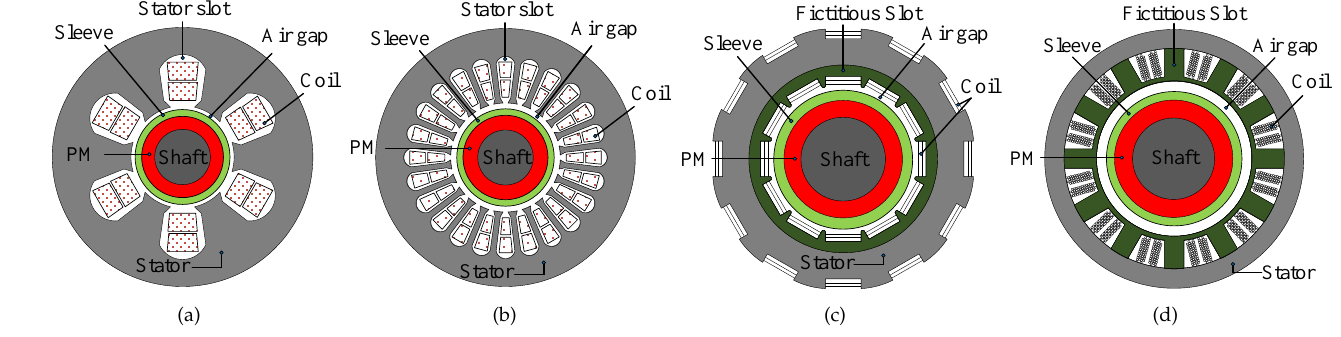
Figure 7. Stator configurations with different number of slots: ( a ) Few-slot structure; ( b ) Multi-slot structure; ( c , d ) is fictitious